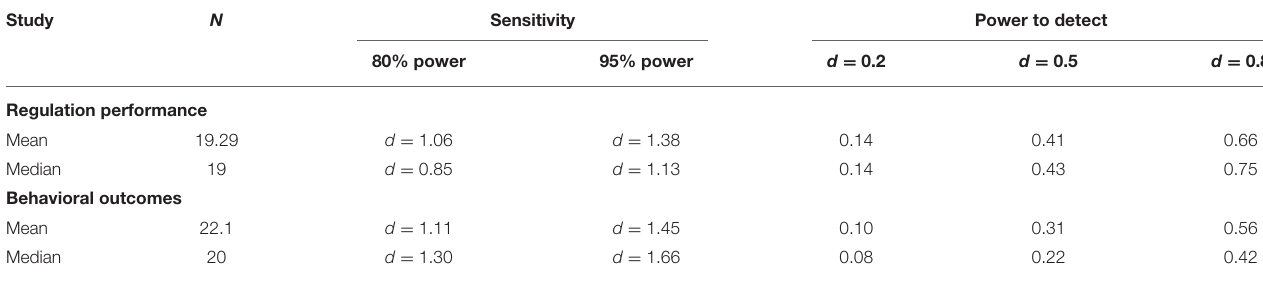
TABLE 5 | Sensitivity and statistical power for reported analysis.